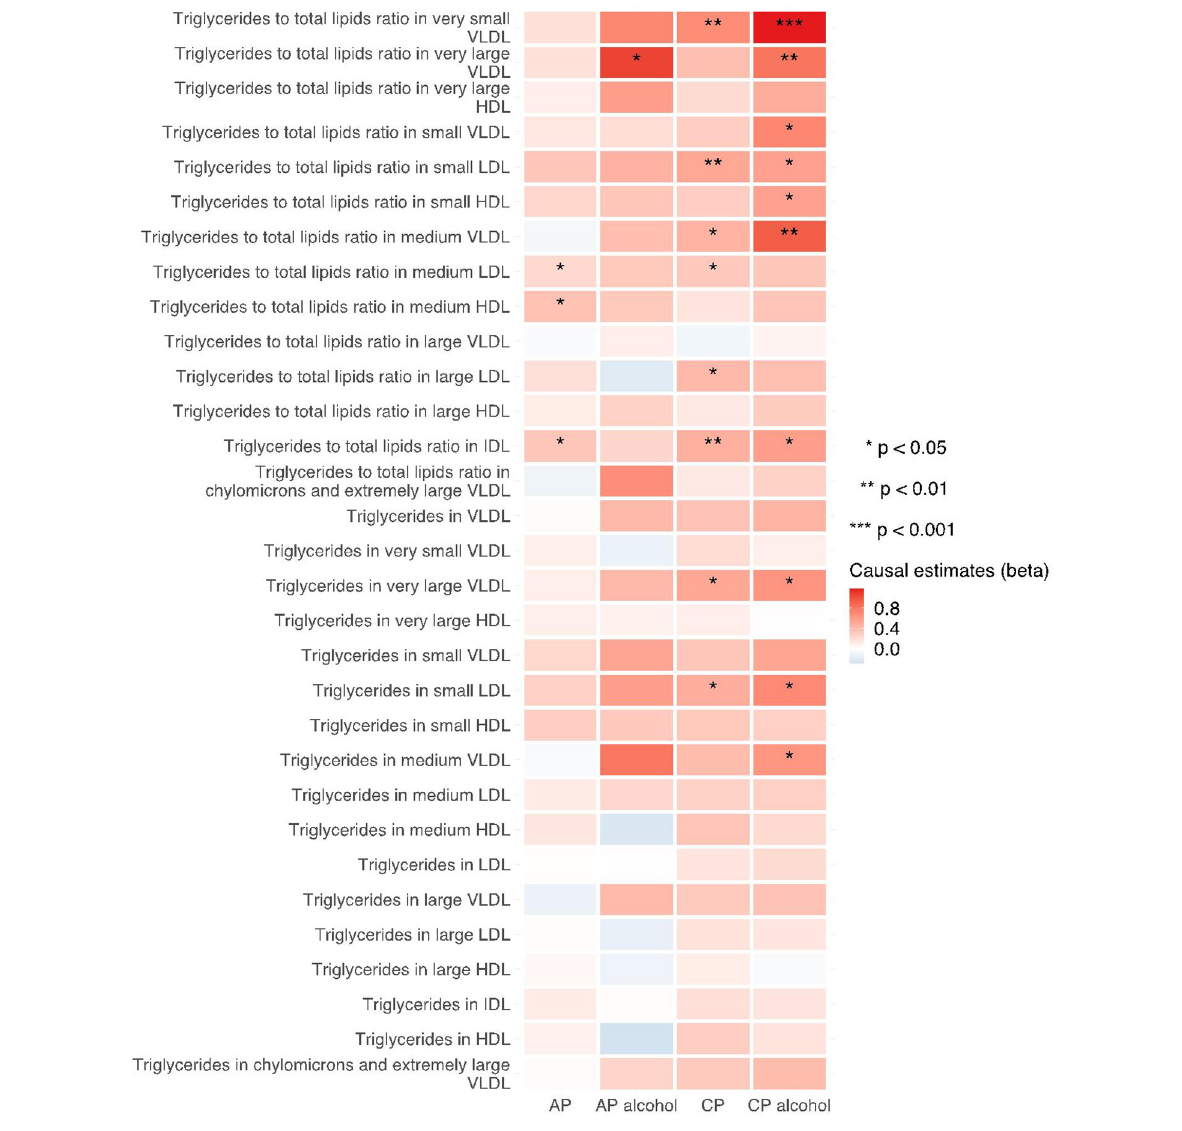
FIGURE4 Heatmap showing the MR-egger causal estimates of triglycerides related traits in met-d on pancreatitis using two-sample MR. AP, acute pancreatitis; CP, chronic pancreatitis; IVW, inverse-variance weighted; VLDL, very-low-density lipoprotein; LDL, low-density lipoprotein; IDL, intermediate-density lipoprotein; HDL, high-density